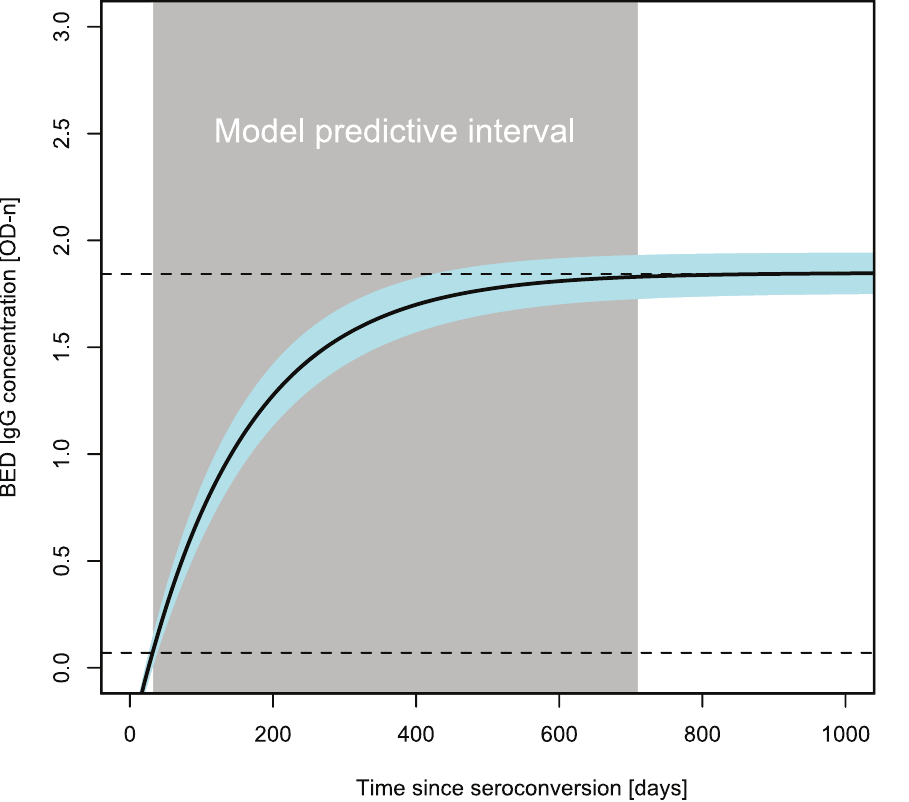
Figure 2. Logistic modeling of IgG-capture BED-enzyme immunoassay absorbance as a function of time since seroconversion. The resulting logistic model is predictive when BED OD-n=(0.07, 1.84), corresponding to 31–711 days. This model describes the typical patient estimated by the SAR mixed effects model (Table 1), where parameter values correspond to the whole population.